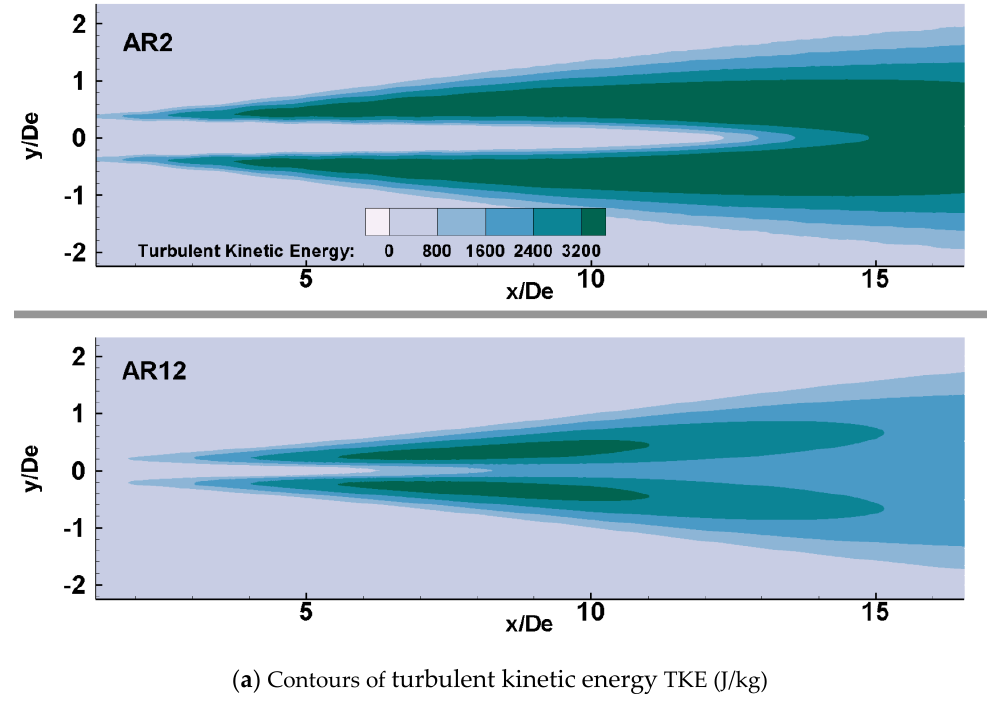
Figure 8 . Contours of entropy J/(kg·K) zoomed in at nozzle exit in AR2 and AR12 nozzle on minor axis symmetry plane.